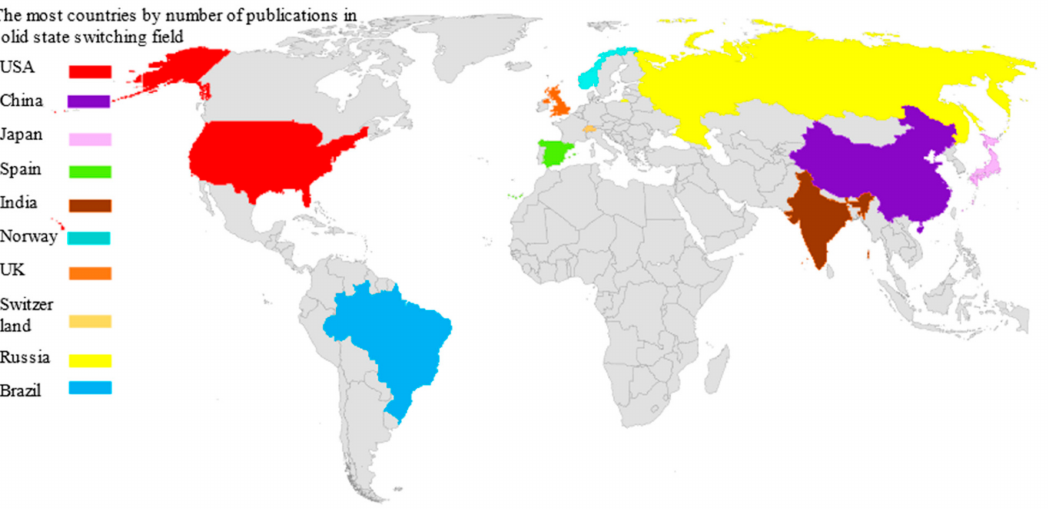
Figure 7. Map of ten countries that dominate the solid state switching